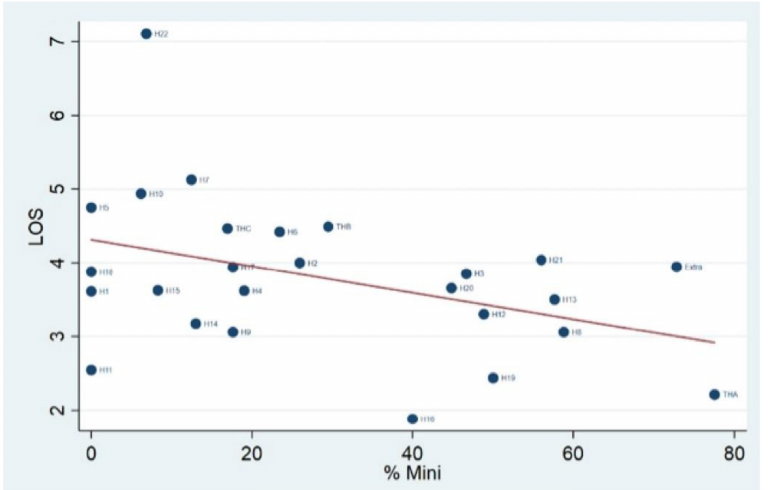
Figure 4. Correlation between average length of stay and use of minimally invasive approach.